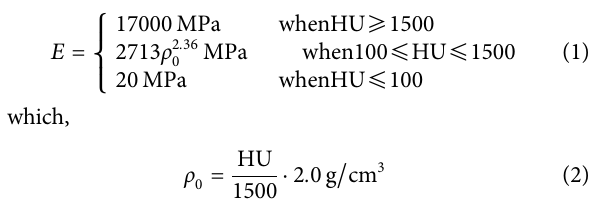
Frontiers in Bioengineering and Biotechnology |